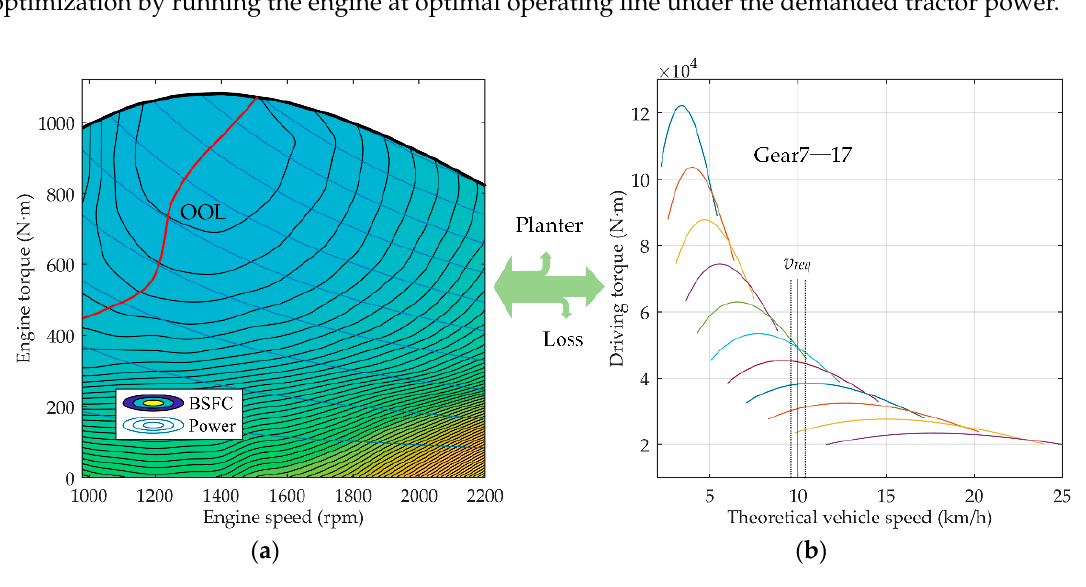
Figure 8. ( a ) Engine universal performance; ( b ) Tractor driving torque.